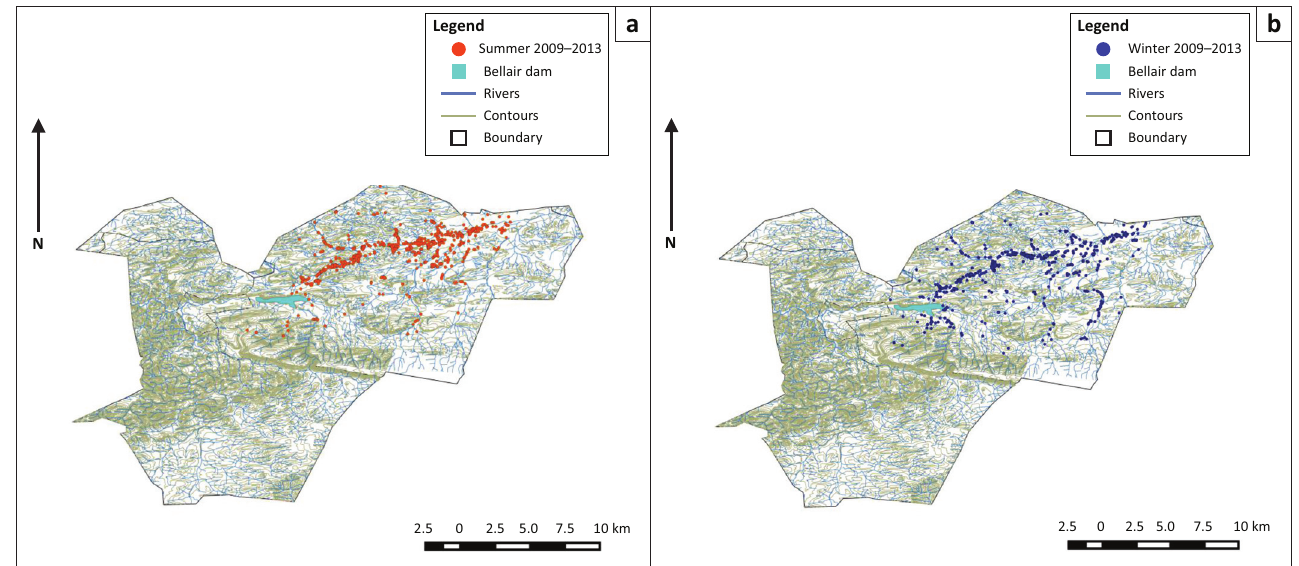
FIGURE 1: Seasonal movement and distribution of giraffe on Sanbona. (a) The summer movement pattern, (b) winter movement pattern. The summer and winter maps showed the largest visual difference, with summer showing a strong clustering around the Brak River and winter showing movement into the smaller